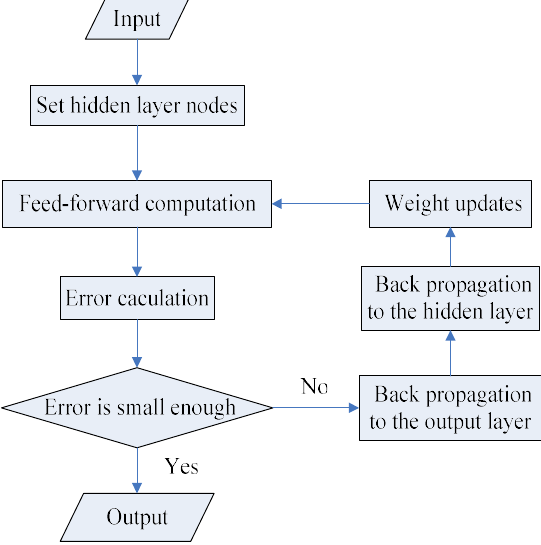
Figure 2. The BP neural network imagery geometrical